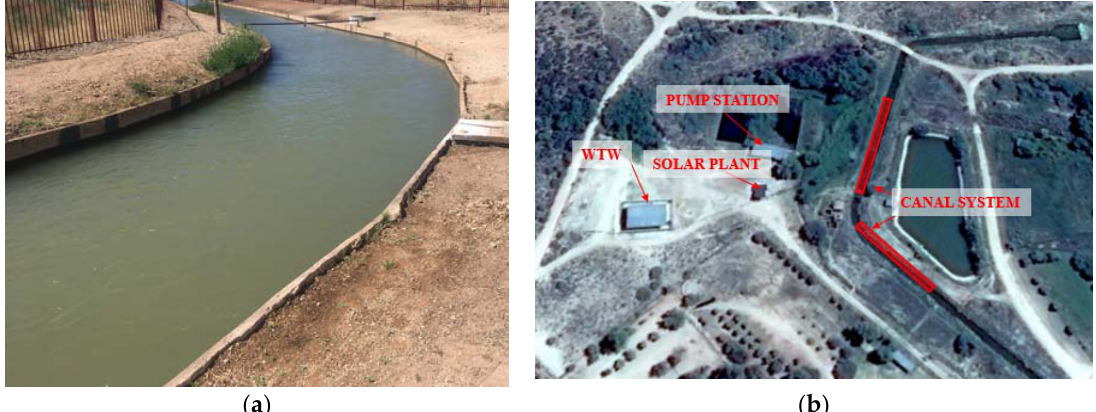
Figure 2. Typical canal testing site. ( a ) canal bend view ( b ) canal